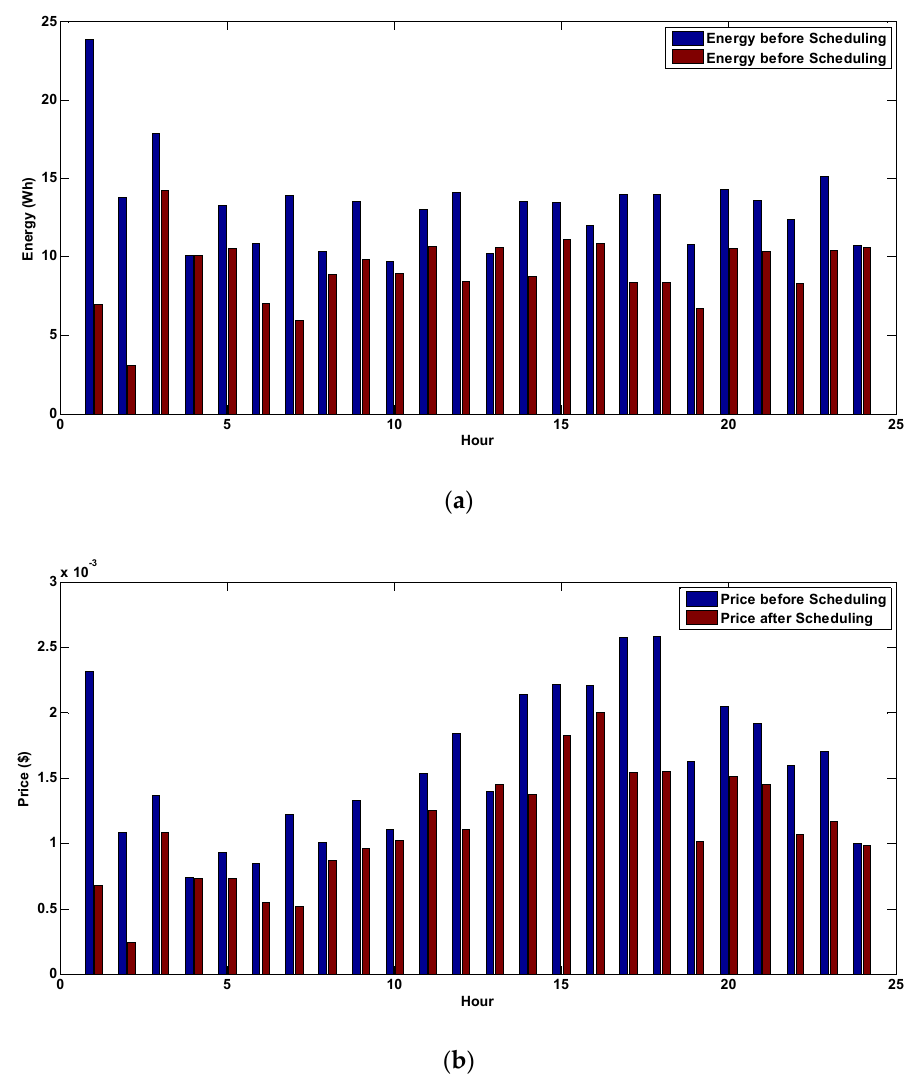
Figure 22. ( a ) Energy consumptions and ( b ) bills incurred by the refrigerator without and with the use of the HEM system.